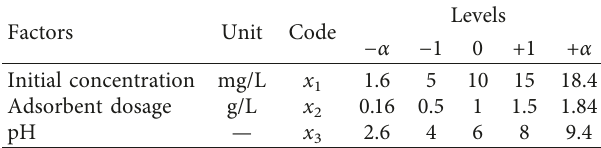
Table 1: List of independent variables and their